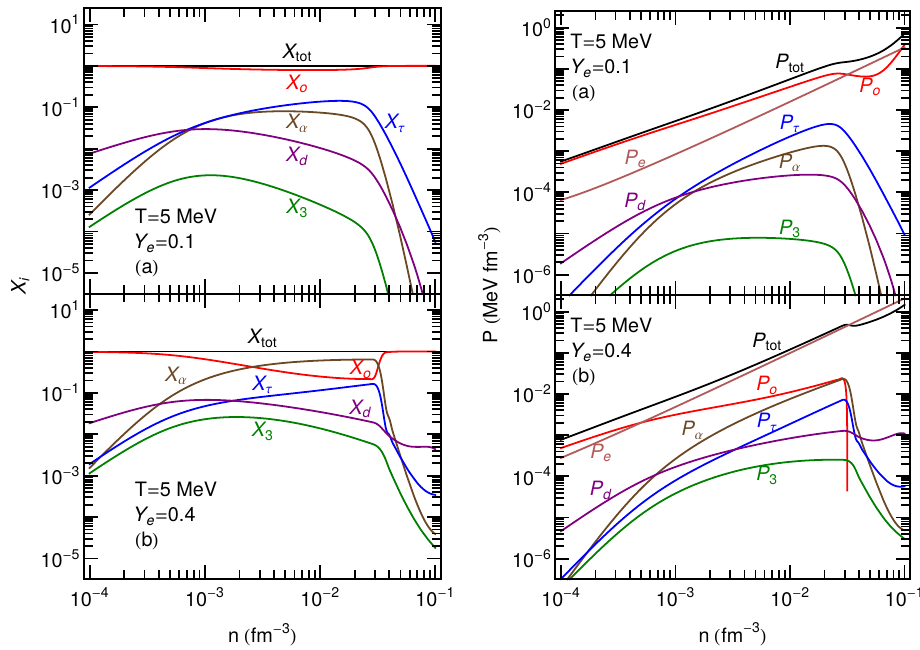
Figure 2. Mass fraction X i = A i n i / n ( left ) and pressure ( right ) as a function of baryon density for different electron fractions at T = 5 MeV shown for the APR/EV approach. The subscripts d , τ , 3, α , e , and o correspond to contributions from deuterons, tritons, 3 He, alpha particles, electrons and outside nucleons (nucleons not bound in nuclei). The total mass fraction (=1) and total pressure are given by X tot and P tot , respectively.